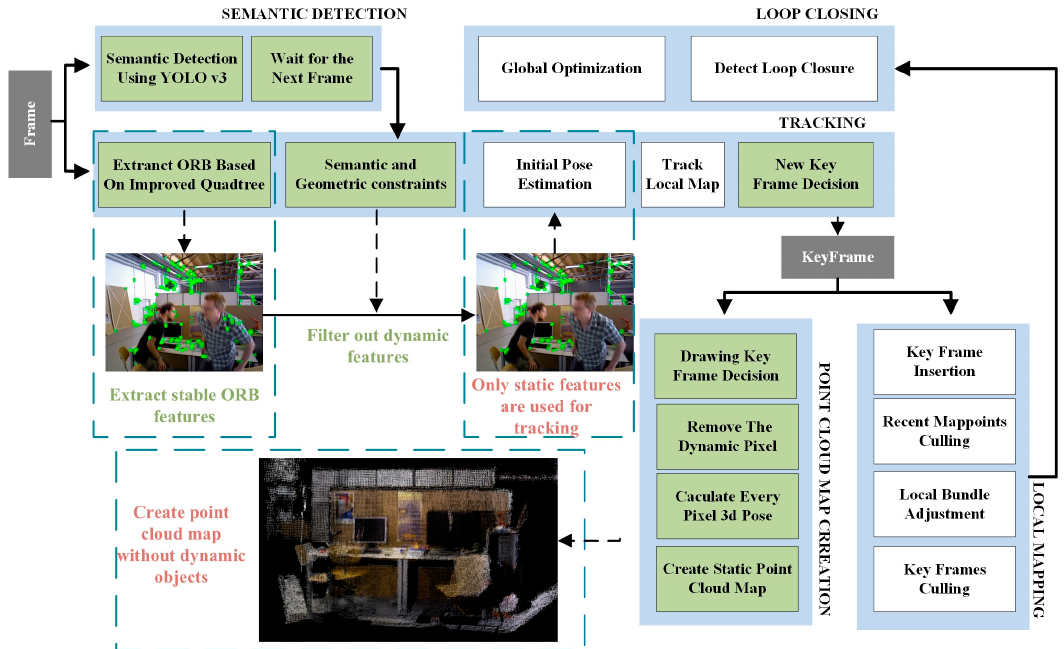
Figure 1. Overall-architecture for SGC-VSLAM. The improved quadtree-based, semantic and geometric constraints’ methods are integrated into the tracking thread, among which only the static features are used to calculate and optimize the camera pose. A semantic detection thread is added to detect objects labelled as dynamic, and a static point cloud map is created from the point cloud map creation thread.